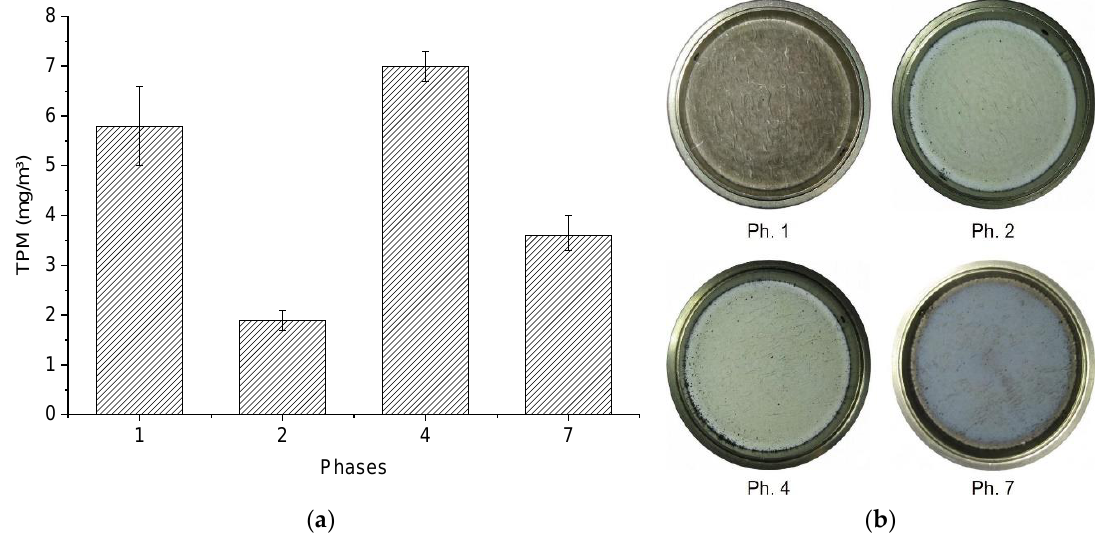
Figure 4. Particle emissions for the different process phases; ( a ) average TPM emissions (error bar: min./max. values); Ph. 1, Ph. 2 and Ph. 4 within experiment 1 – 2; Ph. 7 within experiment 3 – 6; ( b ) filter from particle measurement for start-up (Ph. 1), pyrolysis (Ph. 2), char-burn (Ph. 4) and overall process (Ph. 7).